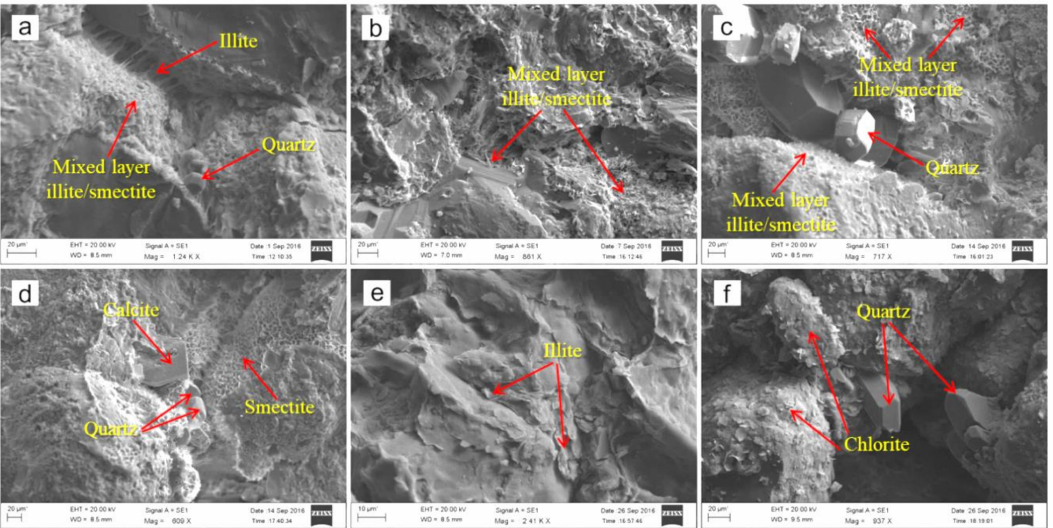
Figure 3. Scanning electron micrograph of sandstone from the Xiaganchaigou Formation (Xx 1 well). ( a ) 4111.51 m, upper Xiaganchaigou Formation, filamentous illite, mixed layer illite / smectite, and other clay minerals filled between particles and particle surfaces; ( b ) 4115.37 m, upper Xiaganchaigou Formation, mixed layer illite / smectite filled between particles and particles surfaces; ( c ) 4209.77 m, upperXiaganchaigouFormation, interstitialcalcite, self-generatedandenlargedquartz. Particlesurfaces develop a mixed layer illite / smectite clay mineral; ( d ) 4122.14 m, upper Xiaganchaigou Formation, interstitial calcite. Particle surfaces develop a mixed layer illite / smectite clay mineral; ( e ) 4850.00 m, lower Xiaganchaigou Formation, curved leaf-like illite clay completely filled in intergranular pores; ( f ) 4853.05 m, lower Xiaganchaigou Formation, intergranular pores are developed, self-generated and enlarged quartz. Chlorite is developed on the particle